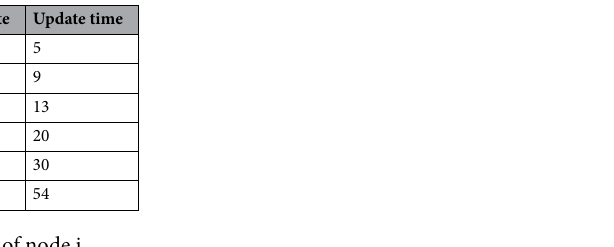
Table 2. Contact rate estimation table of node i.